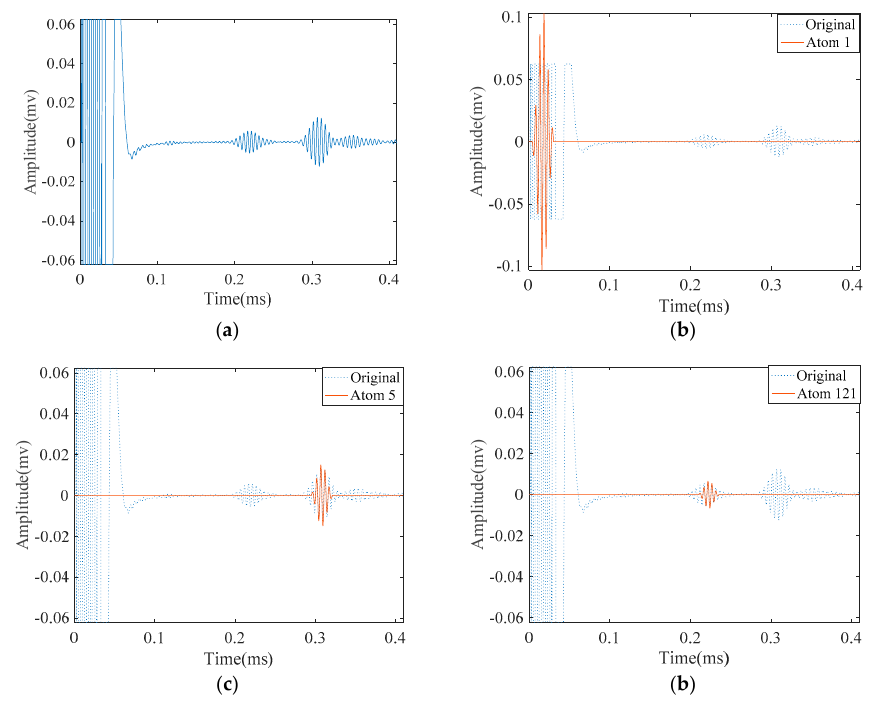
Figure 15. The experimentally measured signal in a cracked pipe and its approximation by MP: ( a ) the original measured signal; ( b ) approximated atom 1—the incident signal; ( c ) approximated atom 5—the reflection from the pipe end; and ( d ) approximated atom 121—the reflection from the crack.